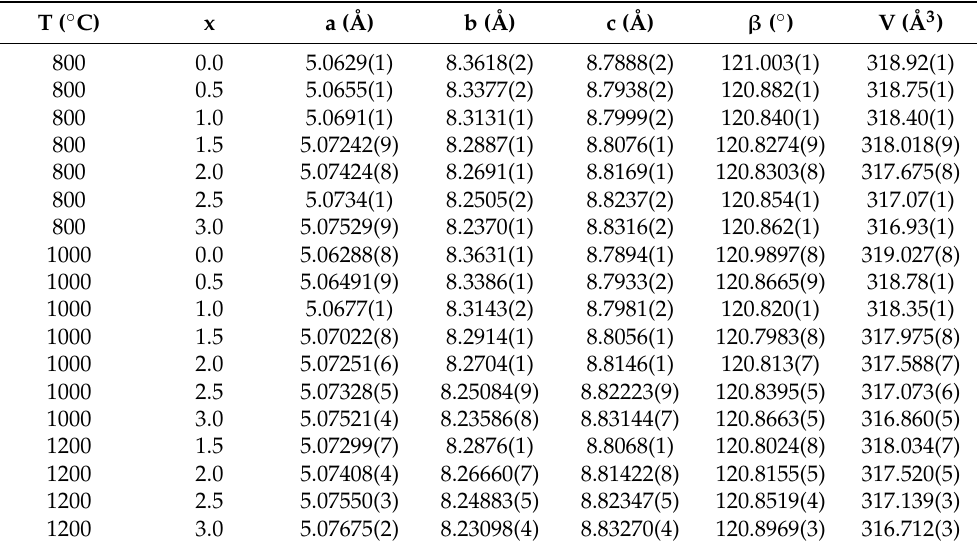
Table 2. Variations in unit cell parameters in the stable Co 3 P 2 O 8 structure obtained from fired